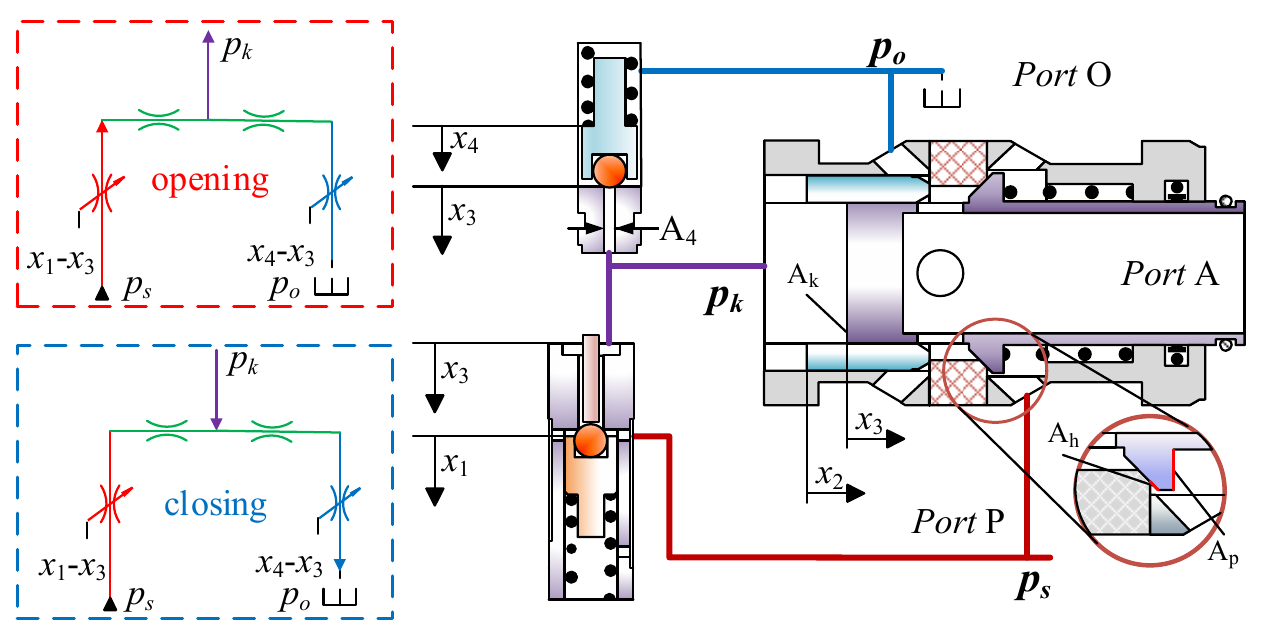
Figure 2. Control schematic of the proportional valve.